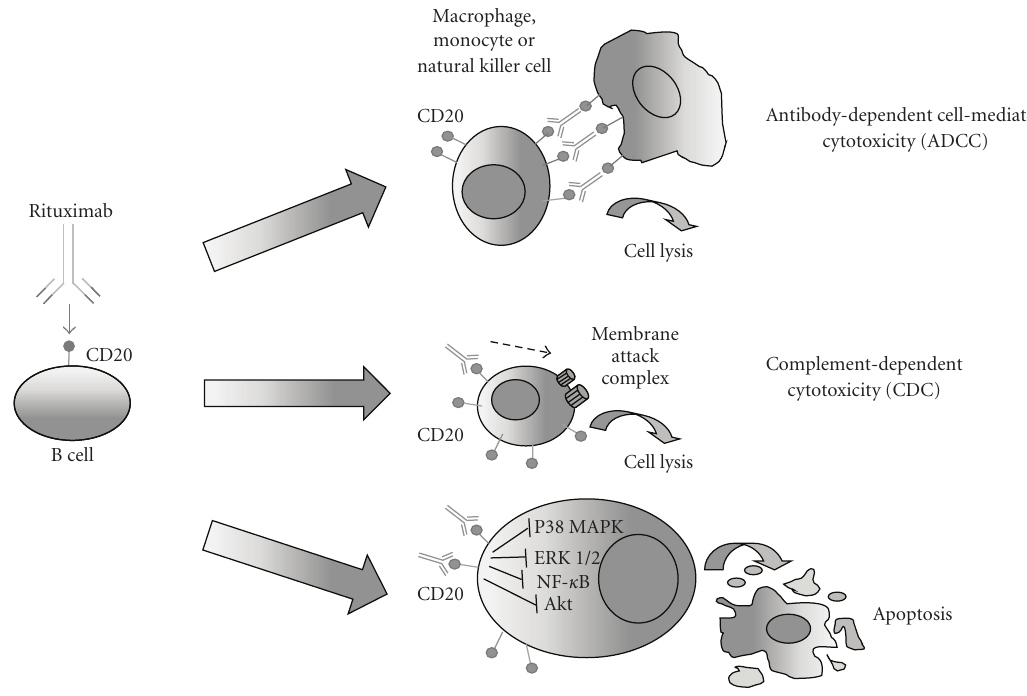
Figure 1: Schematic representation of the putative mechanisms mediating rituximab’s anticancer activity in NHL cells. The anti-CD20 monoclonal antibody rituximab has several mechanisms of action, including antibody-dependent cellular cytotoxicity (ADCC), which involves recruitment of e ff ector cells, mediated by Fc γ receptors; complement-dependent cytotoxicity (CDC); apoptosis